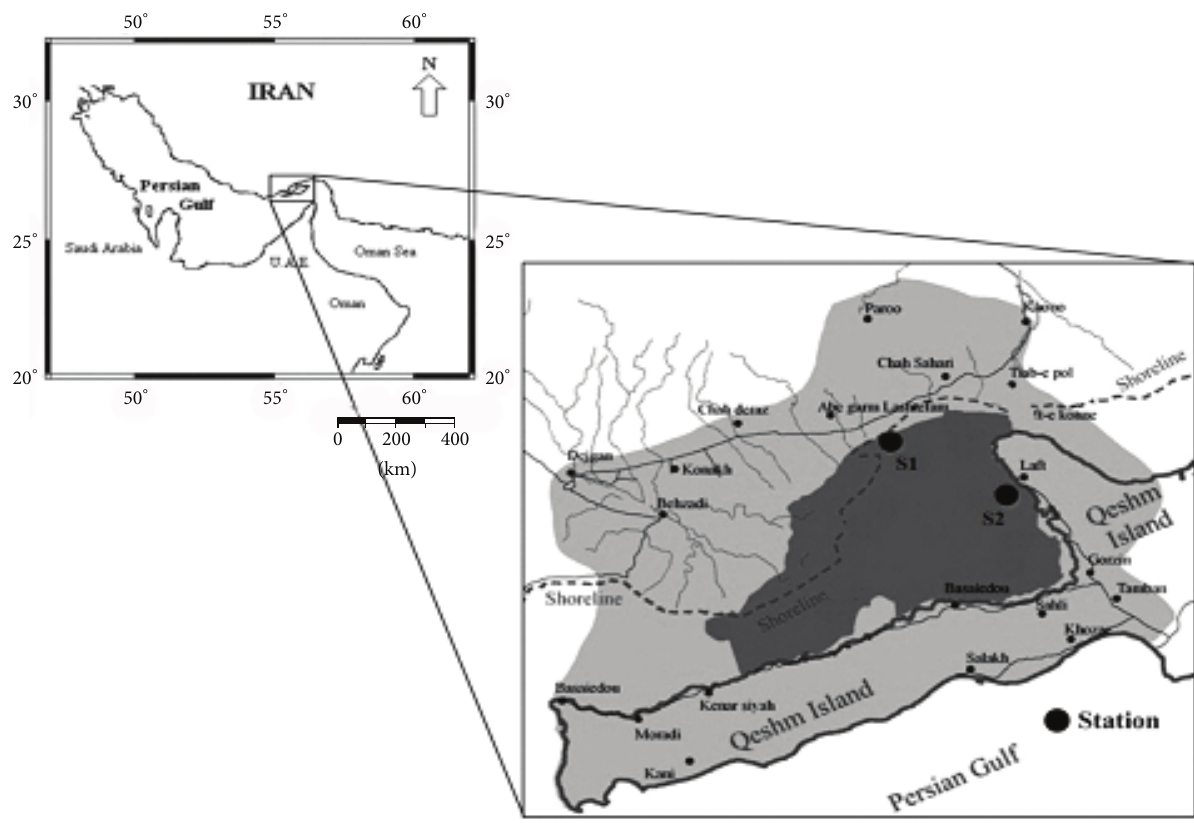
Figure 1: Map of the sampling location (Khamir port (s1) and Laft port (s2)) in Hara biosphere. Table 1: Age, total length (cm), standard length (cm), and wet body weight (g) of fishes. Bartail flathead Silver Factor